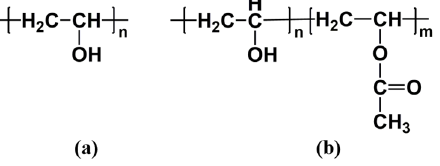
Figure 1. Chemical structure: ( a ) fully hydrolyzed PVA, ( b ) partially hydrolyzed PVA.